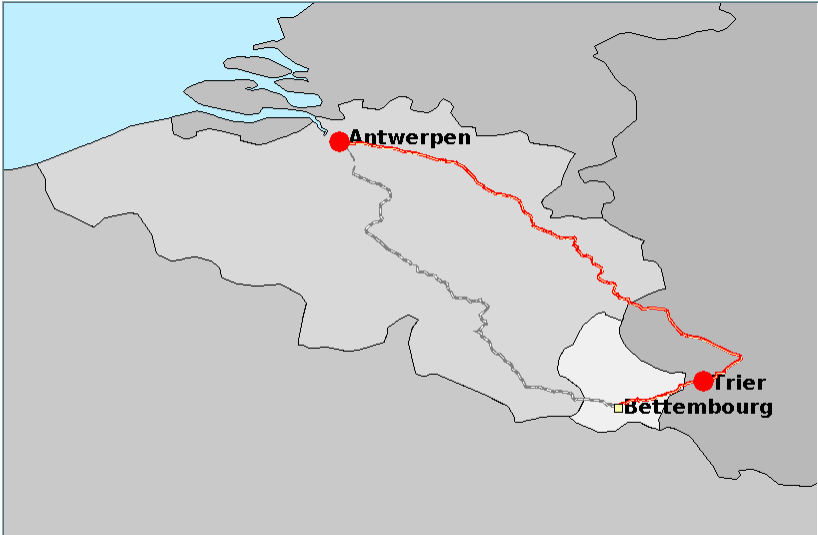
Figure 5. Antwerp –Trier by road and by rail-road via Bettembourg Table 2. Elasticity for total haulage distances (road cost -5%) All Antwerp Rotterdam Short haul Medium haul Long haul Road -0.14 -0.16 -0.10 -0.10 -0.14 -0.19 Rail-Road 0.70 0.81 0.56 0.54 0.71 0.98